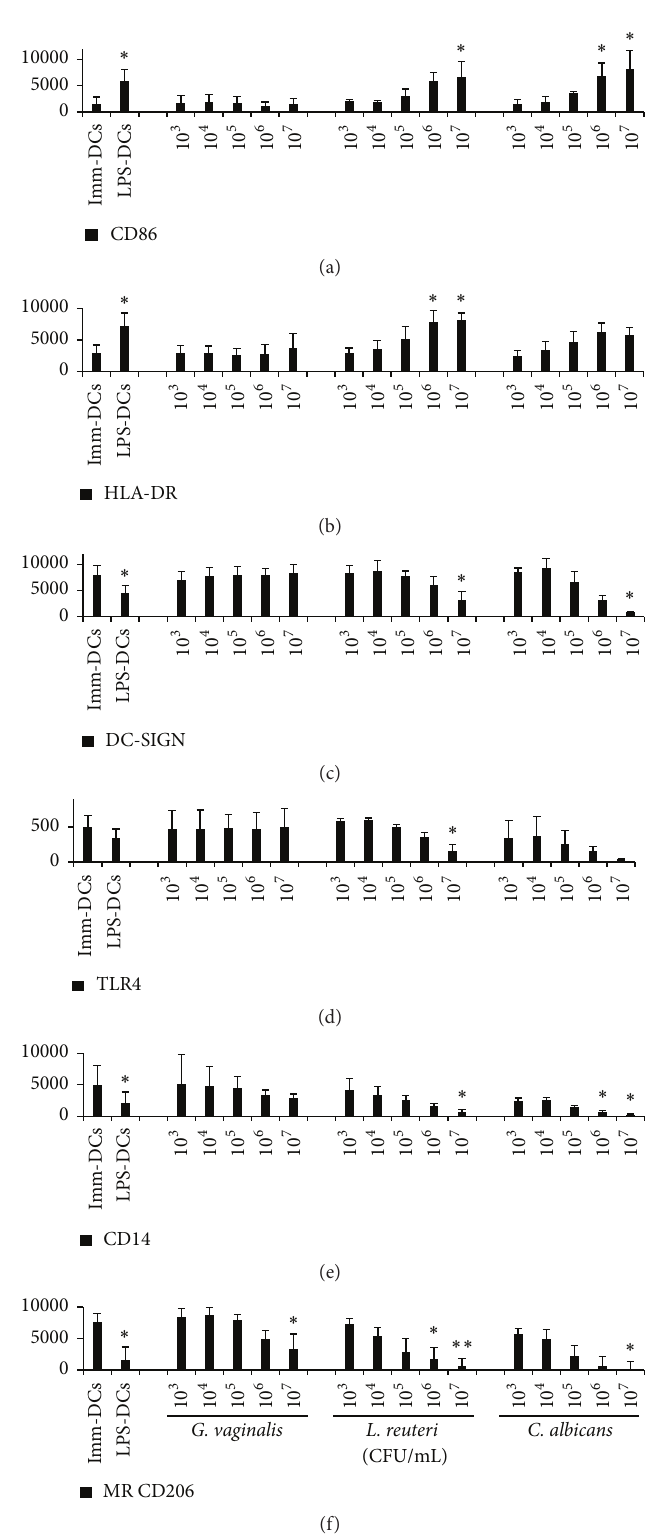
Figure 3: Human DC membrane marker expression after exposure to a range of G. vaginalis, L. reuteri, or C. albicans concentrations. (a, b) Differential expression of CD86 and HLA-DR, two membrane markers typically increasing during DC maturation. (c, d, e, f) Differential expression of DC-SIGN, TLR4, CD14, and MR CD206, four membrane markers typically decreasing during DC maturation. Data are means (+ SD). For every marker, the isotypic control values were subtracted from the MFI values. Imm-DCs: immature DCs, LPS-DCs: DCs matured by a 48 h exposure to 100ng/mL E. coli LPS; G. vaginalis , L. reuteri , and C. albicans : DCs matured after a 48 h incubation at different concentrations (10 3 to 10 7 CFU/mL, i.e., MOI = 0.01 to 100) of G. vaginalis ( 𝑛 = 5 ), L. reuteri ( 𝑛 = 3 ), and C. albicans ( 𝑛 = 2 ). Kruskal-Wallis test with Dunn comparison. ∗ 𝑝 < 0.05 , ∗∗ 𝑝 < 0.01 , as compared to the